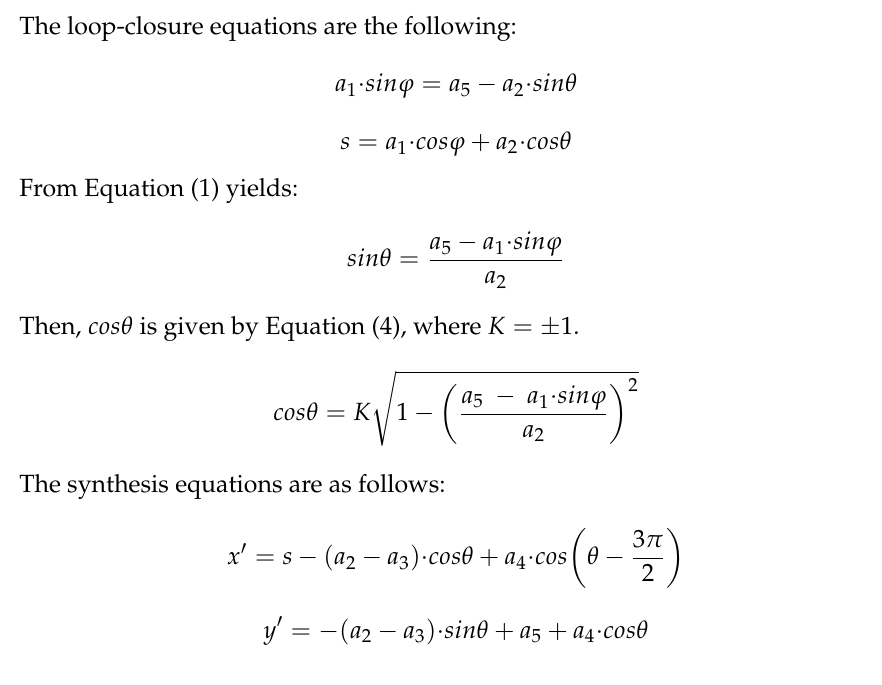
Figure 1. Slider-crank mechanism with 5 dimensional parameters.